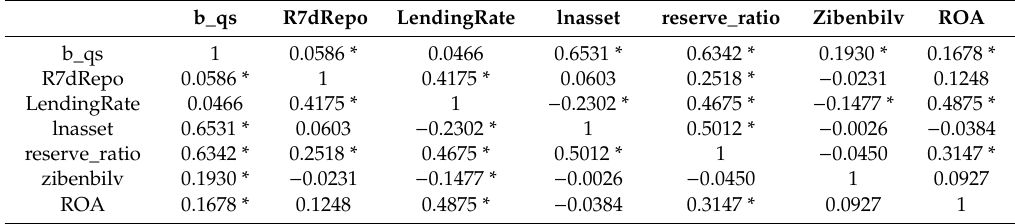
Table 3. The correlation coe ffi cient matrix for the main variables.